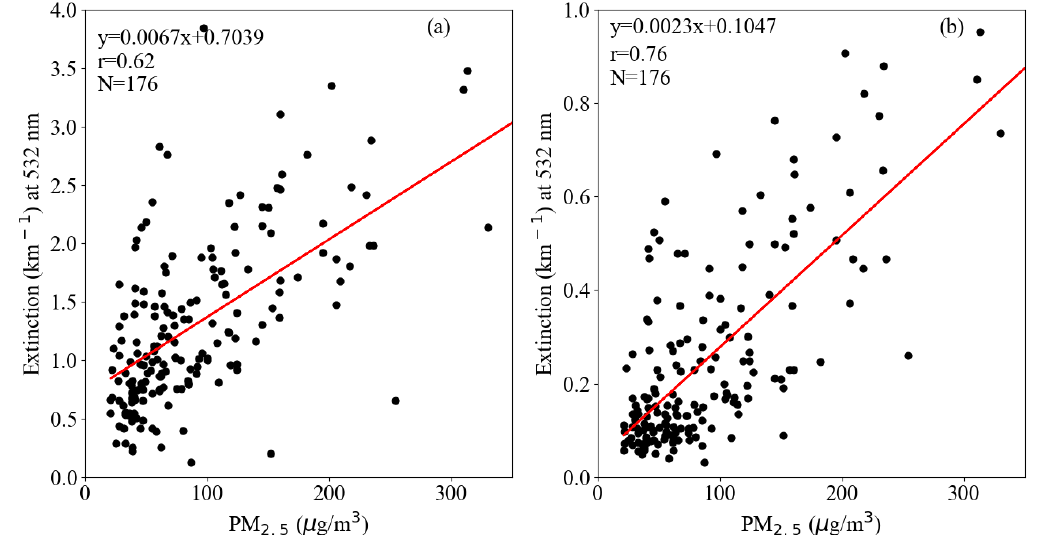
Figure 10. Correlation analysis between the aerosol extinction coefficient and the fitted surface-level PM 2.5 concentration for the site of Southwest Jiao-tong University. ( a ) Results from vertical correction; and ( b ) Results from the vertical and humidity corrections.